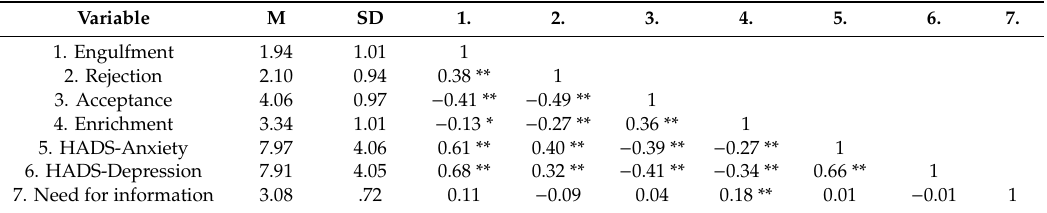
Table 5. Means (M), Standard Deviations (SD) and Bivariate Pearson-Correlations. Variable M